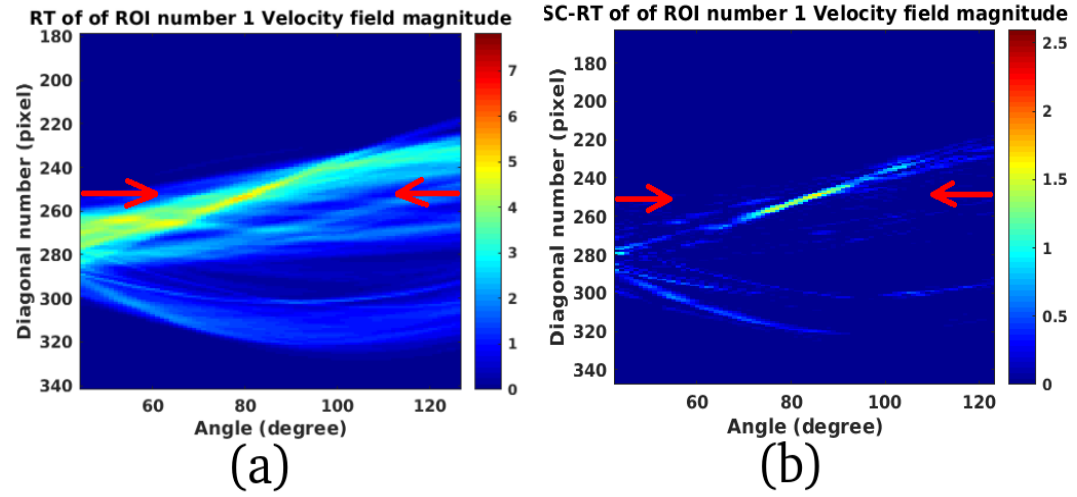
Figure 20. ( a ): RT of the displacement ROI (Particular 2 of Figure 17). ( b ): Sparse component of the RT of the displacement ROI (Particular 3 of Figure 17).